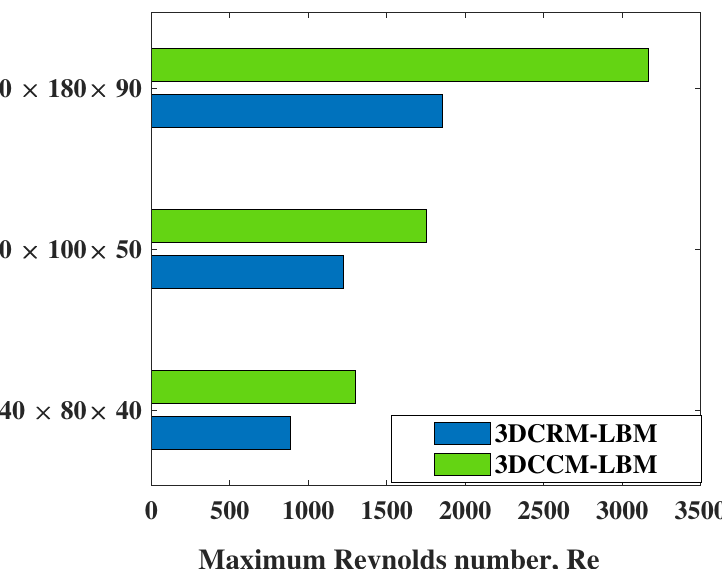
Figure 14. Comparison of the maximum Reynolds number for numerical stability of 3DCCM-LBM and 3DCRM-LBM at different grid resolutions with cuboid grid aspect ratios of r = 0.5 and s = 1.0 for a fixed lid velocity of U = 0.2 and c 2 s =